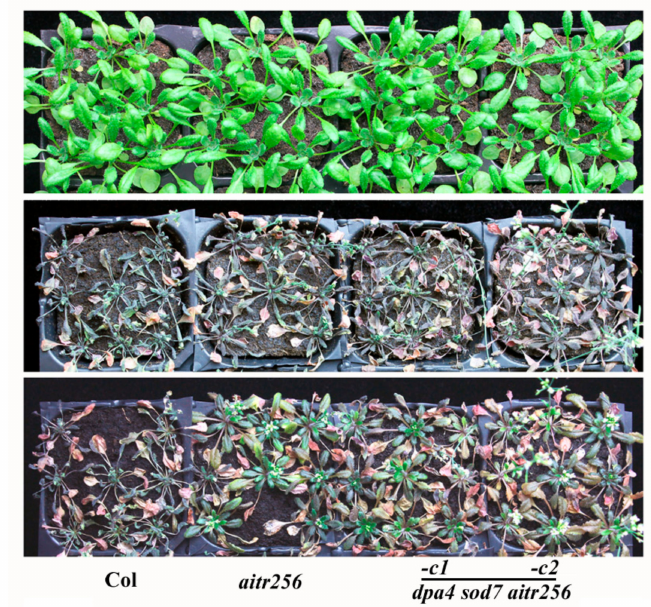
Figure 4. Drought tolerance of the dpa4 sod7 aitr256 quintuple mutants. Seeds of the Col wild type, the aitr256 triple and the dpa4 sod7 aitr256 quintuple mutants were germinated and grown in soil pots for 30 days with su ffi cient watering. The plants were drought treated by withholding water for 12 days, and then watering was resumed. Pictures were taken before and after drought treatment, and 2 days after watering was resumed. Upper panel, before drought treatment, middle panel, after drought treatment, lower panel, 2 days after water was